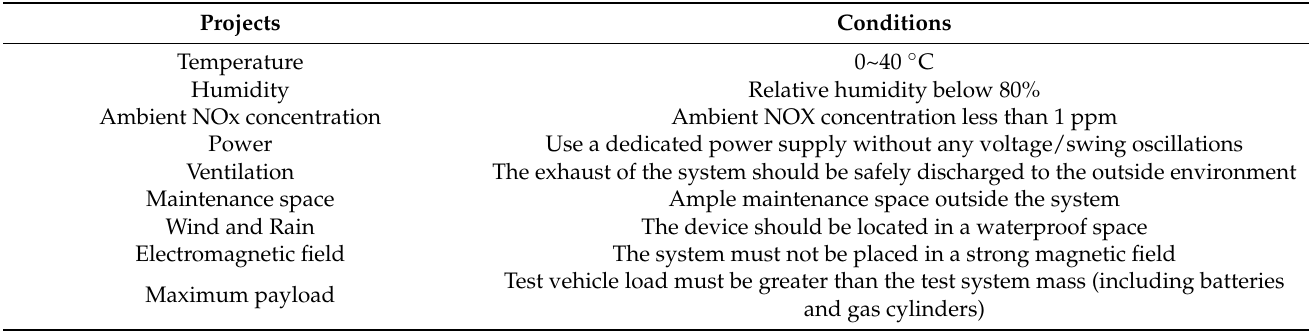
Table 2. Environmental conditions for the use of OBS-ONE.